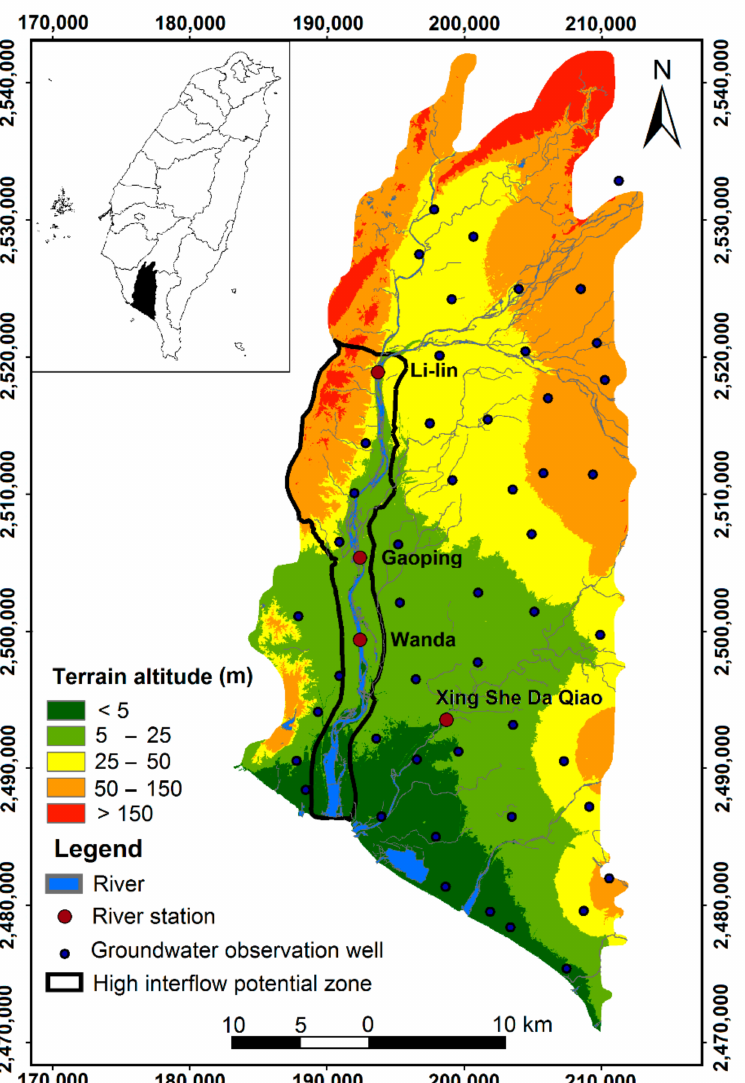
Figure 1. The Pingtung Plain groundwater basin and the selected area for quantifying the interflow potential in the downstream area of the Kaoping River (Modified from Tran et al.